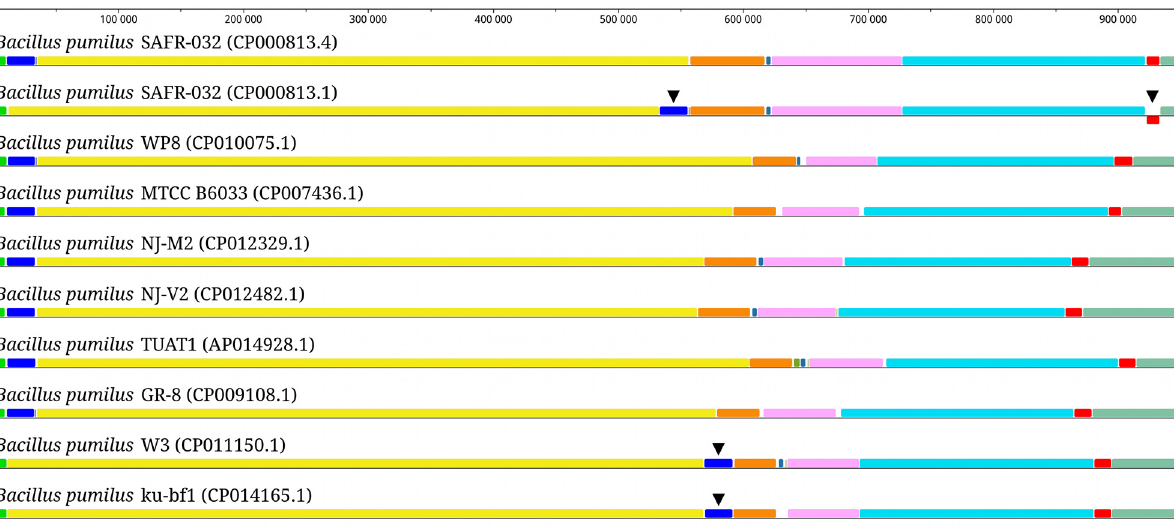
Fig 3. Comparative genome analysis of complete B . pumilus genomes. Multiple genome alignments were performed with Progressive Mauve Aligner [34]. Related segments have the same color in all aligned genomes. Inverted segments are shown below a genome's center line. Only the first 950,000 bp of each genome are shown for the entire alignment (S2 Fig). Both de novo and reference-driven genome assemblies are presented. The problematic genome fragments are marked with black triangles.